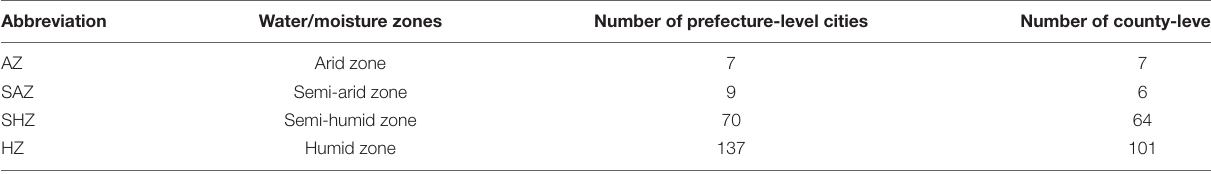
TABLE A2 | Water/moisture zones.